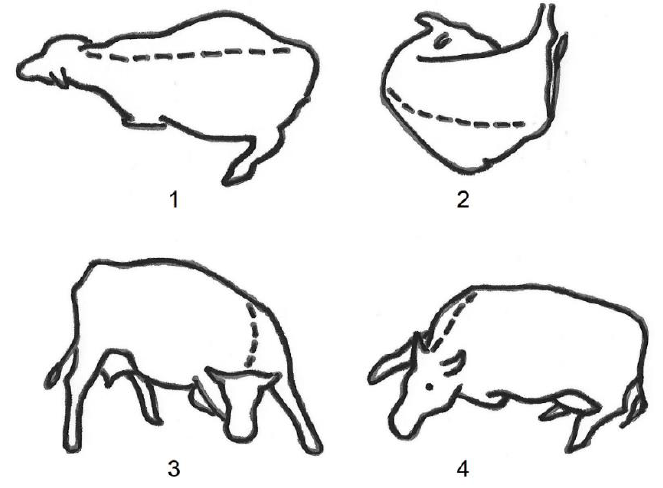
Figure 1. Lying postures of dairy cows: long ( 1 ), short ( 2 ), wide ( 3 ), and narrow ( 4 ). After [8].